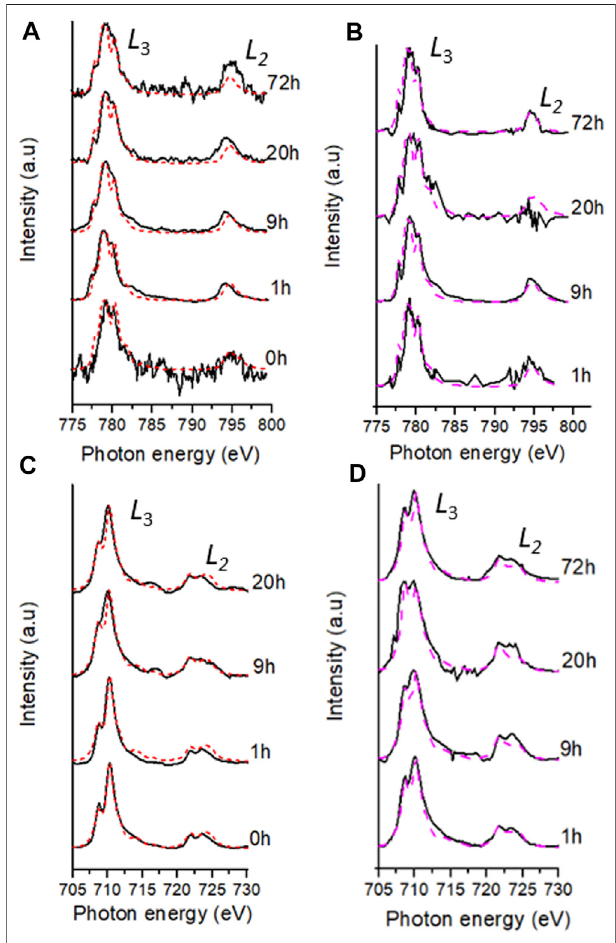
FIGURE 4 | Fe and Co best fi ts (dashed lines) of the experimental data (blacklines)duringthebioreductionofCodopedferrihydritesuspensionusing G . sulfurreducens over 72 h; bulk L 2 , 3 -edge XAS spectra (red lines) for Co (A) and Fe (C) and aggregate SXM data (pink lines) for Co (B) and Fe (D) .